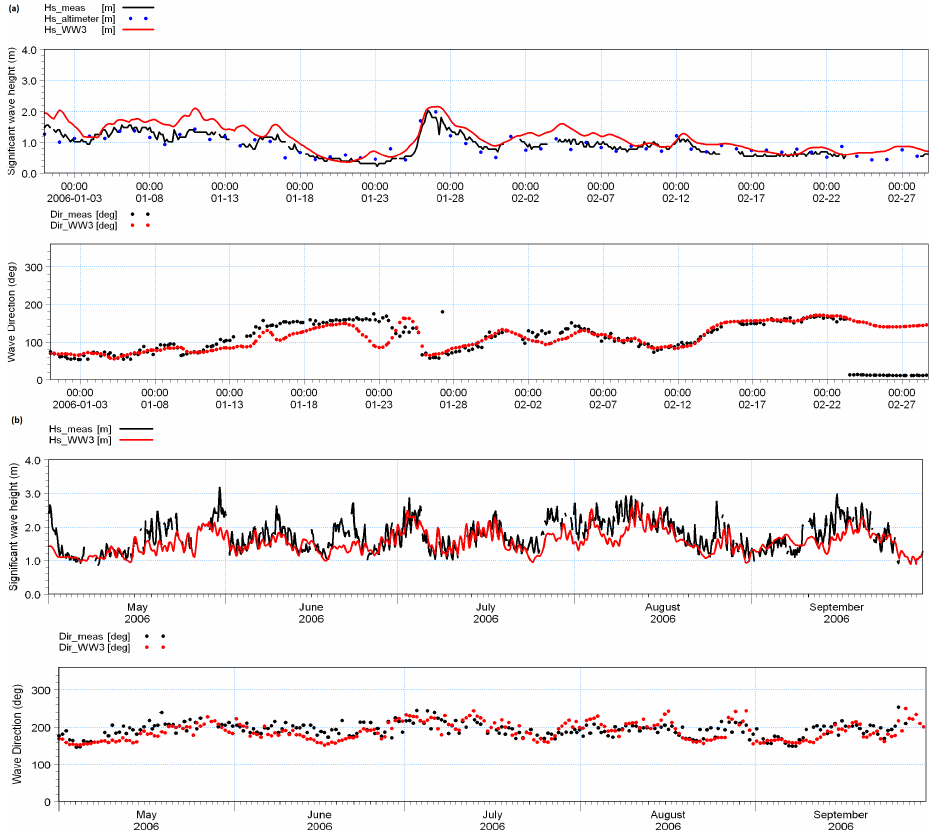
Fig. 3. (a) Comparison between measured (black line) (wave rider buoy) and modelled (red line) wave heights and wave directions for the period January–February 2006 (calm weather season). Altimeter data (blue dots) (deep water: DS5, off Kakinada). (b) Comparison between measured (black line) (wave rider buoy) and modelled (red line) wave heights and wave directions for the period May–September 2006 (rough weather season). (deep water: OB08, off Pondicherry). Table 1. Statistical parameters for wave height obtained by comparing model results with buoy data at a few locations in the Indian Ocean (January–February